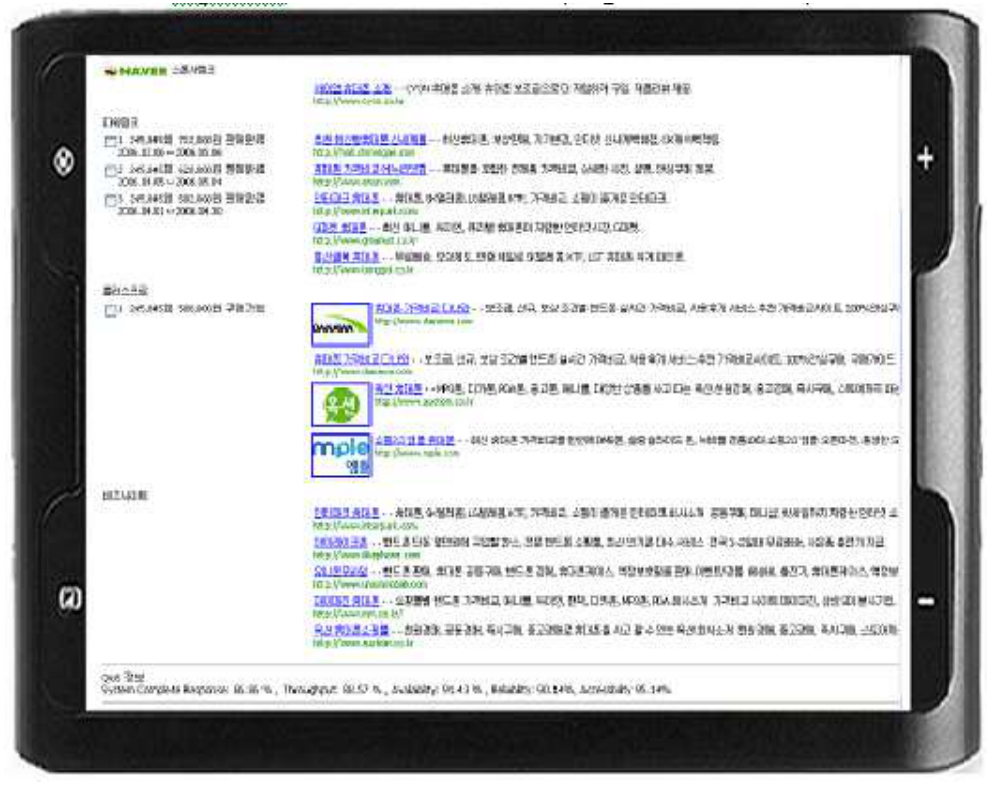
Figure 8. Search Result Screen (English Version